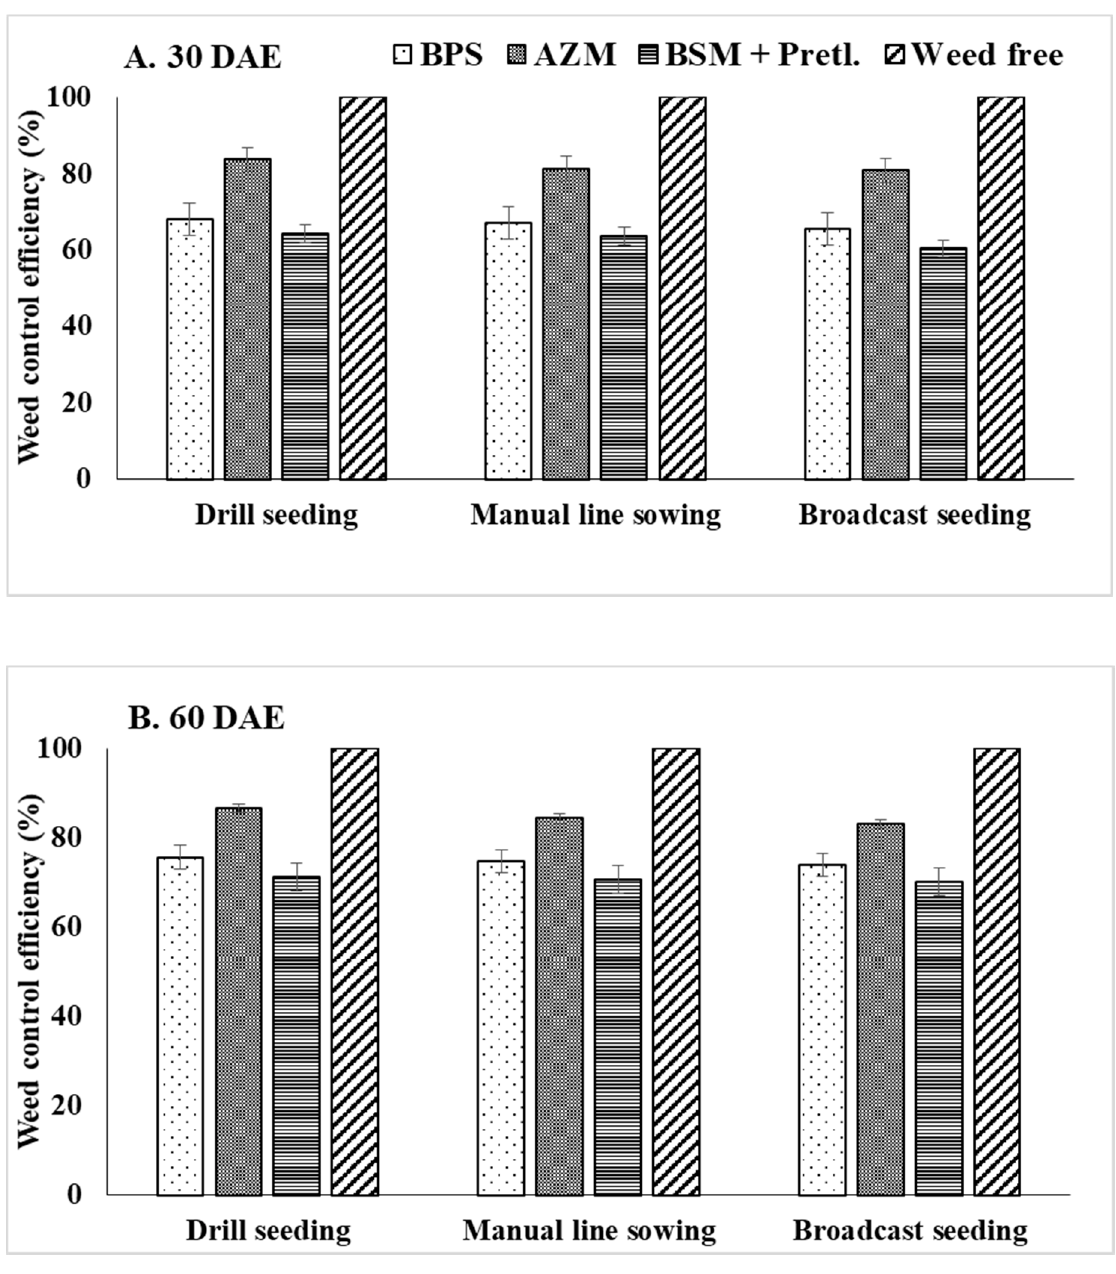
Figure 1. Effect of establishment methods and weed control treatments on weed control efficiency (%) at ( A ) 30 DAE and ( B ) 60 DAE at Cuttack, Odisha. Error bars represent standard error of mean. BPS—Bispyribac-sodium (30 g ha − 1 ); AZM—Azimsulfuron (35 g ha − 1 ); BSM + Pretl.—Bensulfuron-methyl + Pretilachlor (70 + 700 g ha − 1 ).